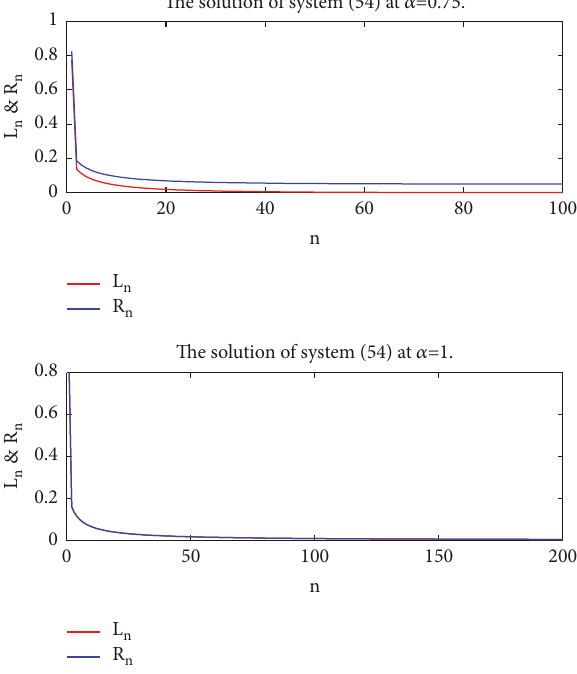
Figure 5: The solution of system (54) at 𝛼 = 0 and 𝛼 = 0.25. The solution of system (54) at  =0.75.